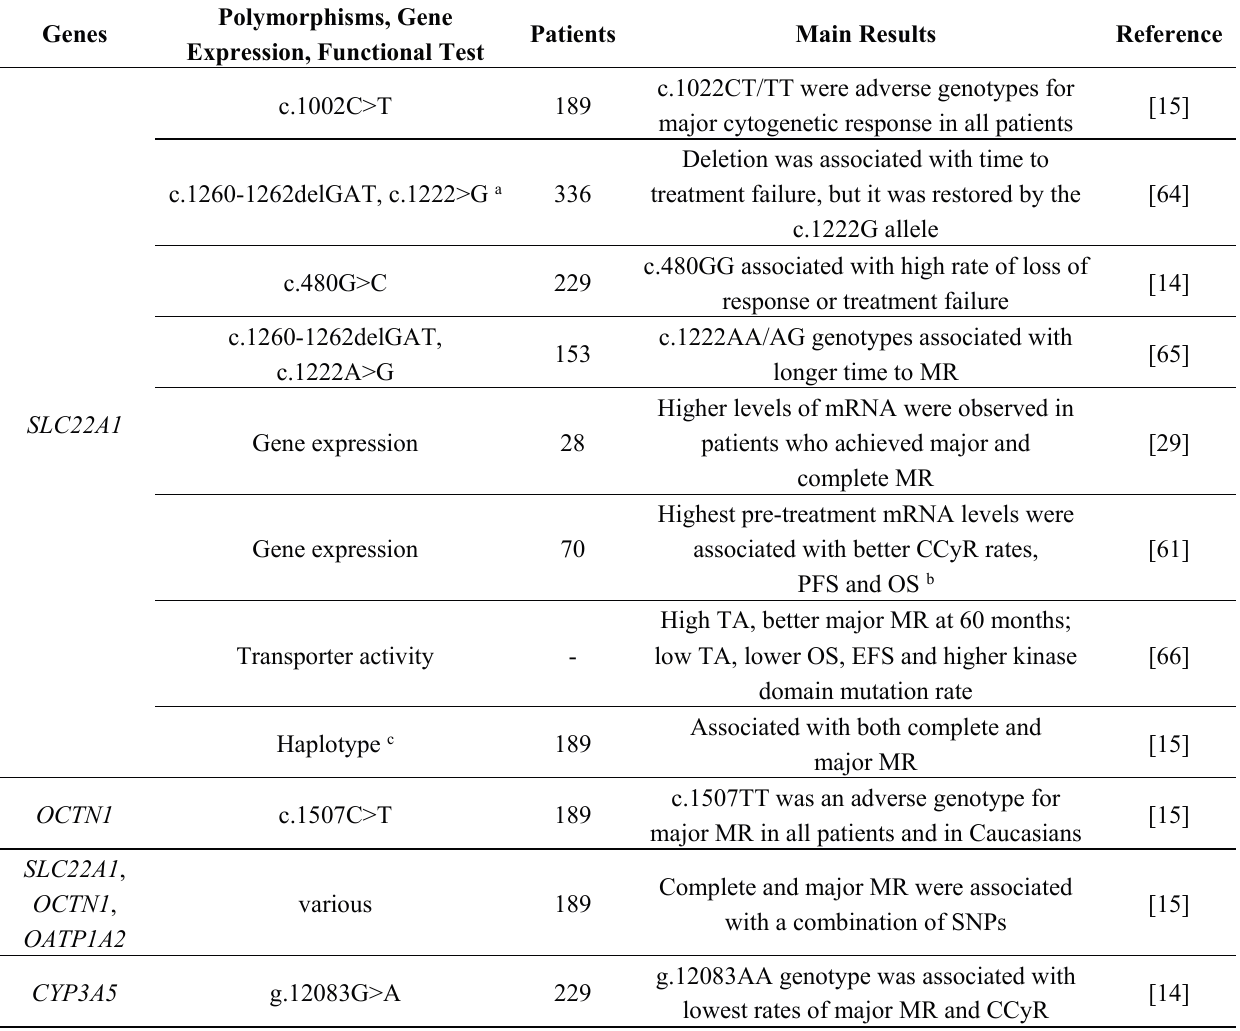
Table 2. Studies evaluating the possible correlation between clinical endpoints and polymorphisms of SLC22A1, OCTN1, OATP1A2 and CYP3A5 genes, their mRNA levels or transporter activity in CML patients treated with